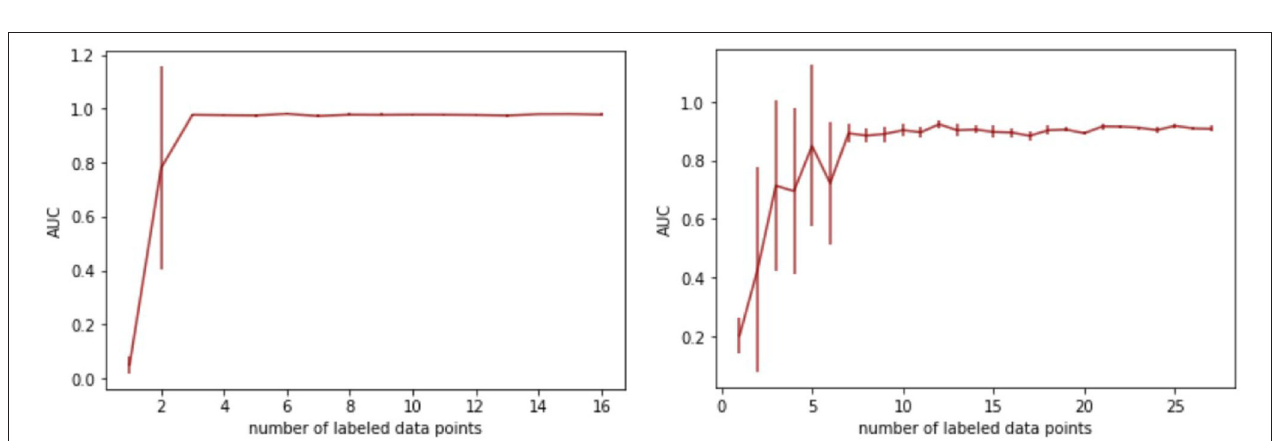
FIGURE 8 | Resulting AUC scores for different training set sizes of the SVM. Left: SoccerVAE for cornerkicks. Right: SeqLabelVAE for counterattacks.